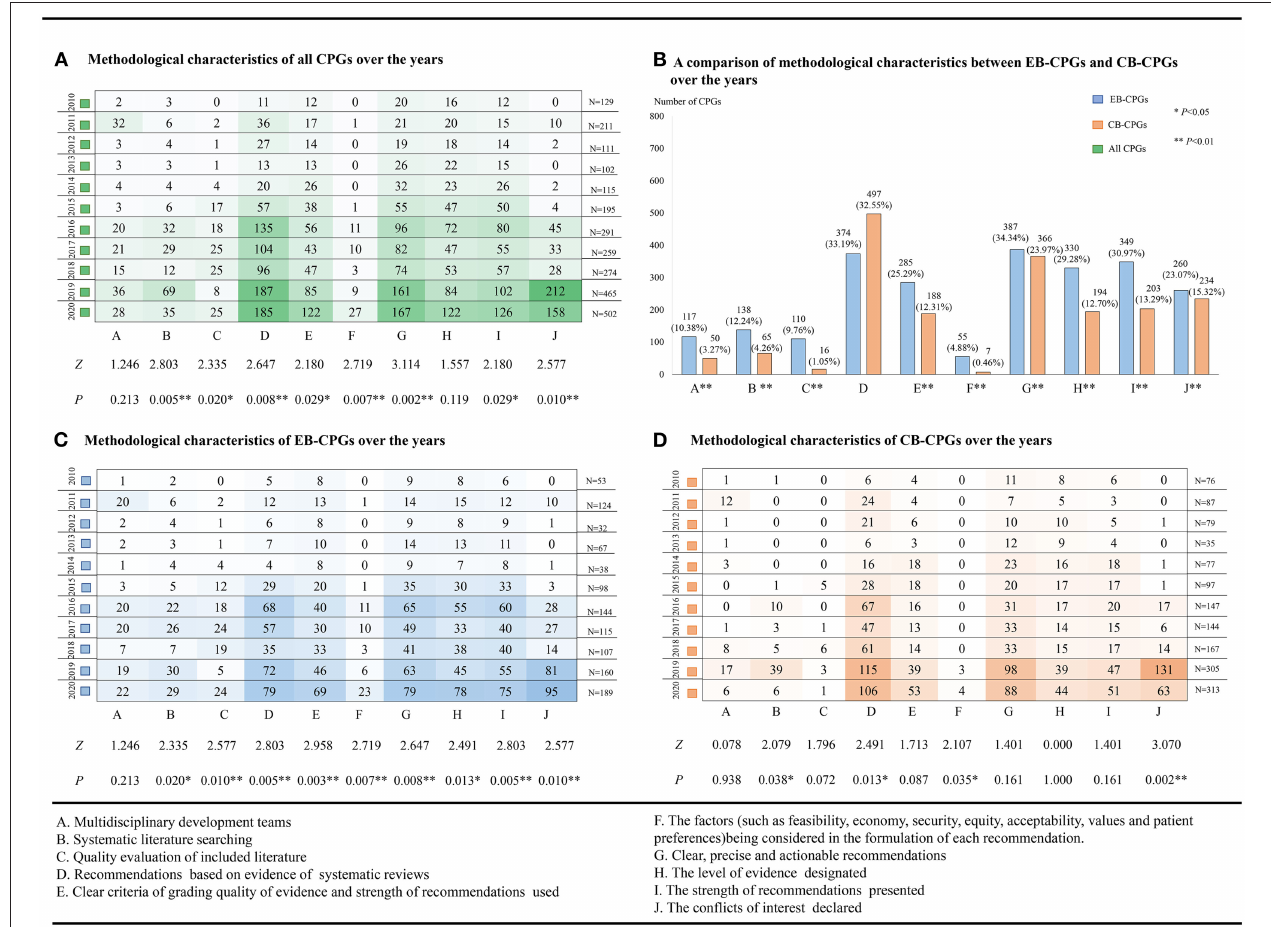
FIGURE 4 | The methodological characteristics of the guidelines from 2010 to 2020. (A) The methodological characteristics of all the clinical practice guidelines (CPGs) over the years. (B) A comparison of the methodological characteristics between evidence-based (EB)-CPGs and consensus-based (CB)-CPGs over the years. (C) The methodological characteristics of EB-CPGs over the years. (D) The methodological characteristics of CB-CPGs over the